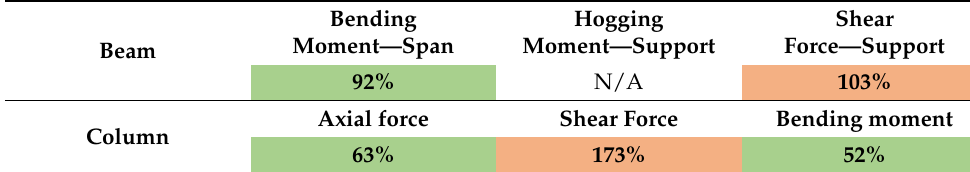
Table 11. ULS verifications of the RC frame (Section